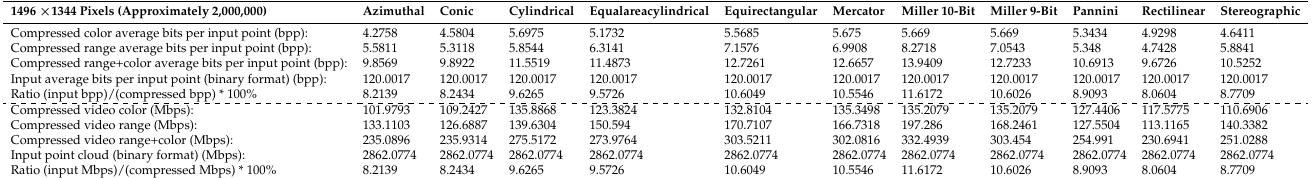
Table 3. Information about the compressed file sizes for different projection types, with projection area of 1496 × 1344 pixels (approximately 2,000,000).